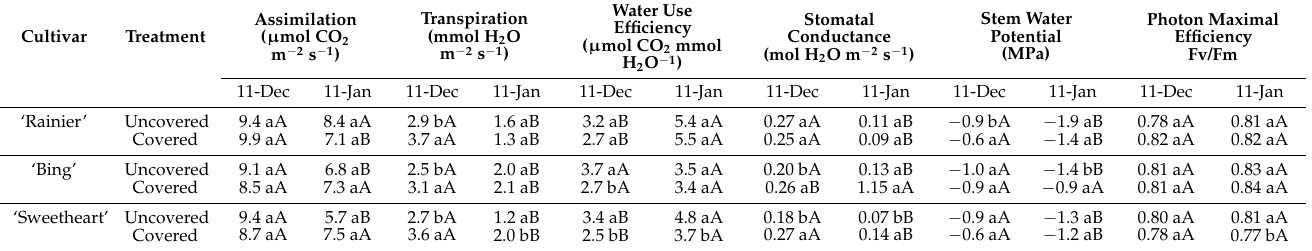
Table 4. Physiological variables in sweet cherry trees cv. ‘Rainier’, ‘Bing’ and ‘Sweetheart’ with and without rain cover on two dates: 11 December 2017 (with fruit); 11 January 2018 (without fruit).